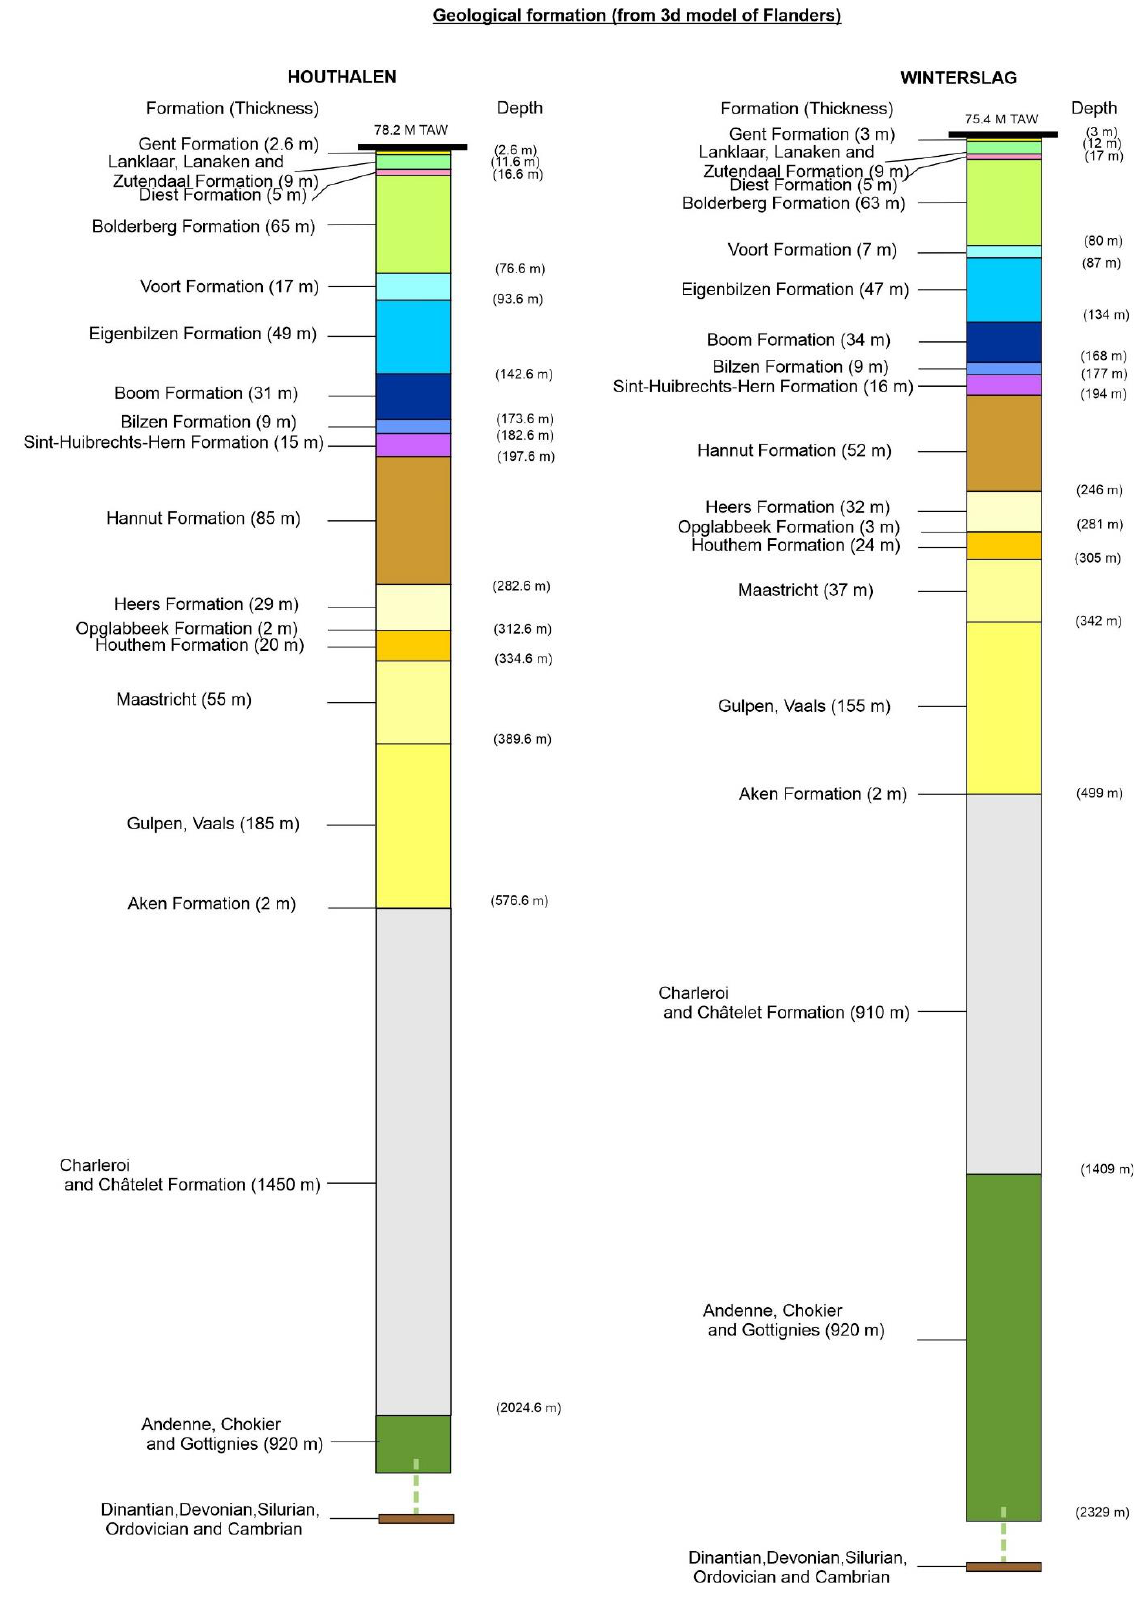
Figure 9. Virtual boreholes from the 3D geological model of Flanders [58], showing the different geological formations encountered in the subcrop of coal concessions in Houthalen and in Winterslag.